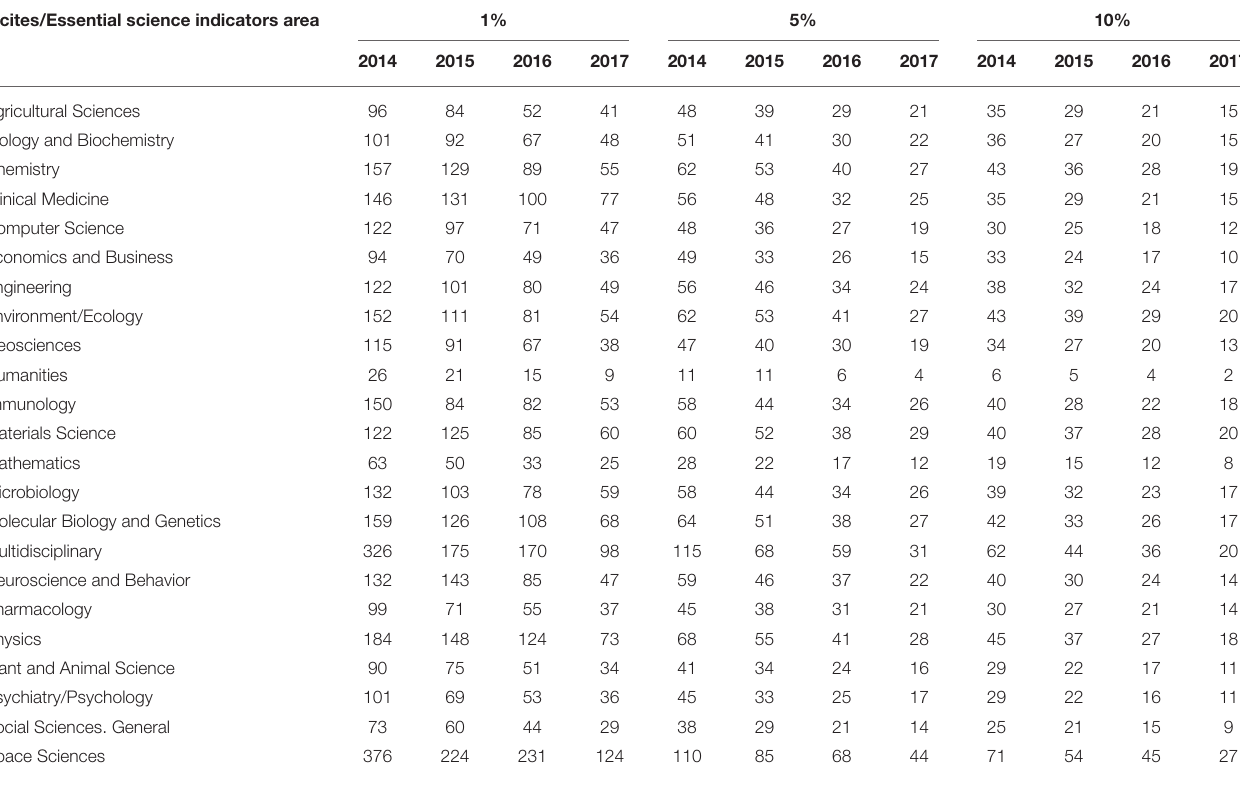
TABLE 1 | HCP-DL lower limit, minimum number of citations needed to qualify as HCP-DL. Incites/Essential science indicators